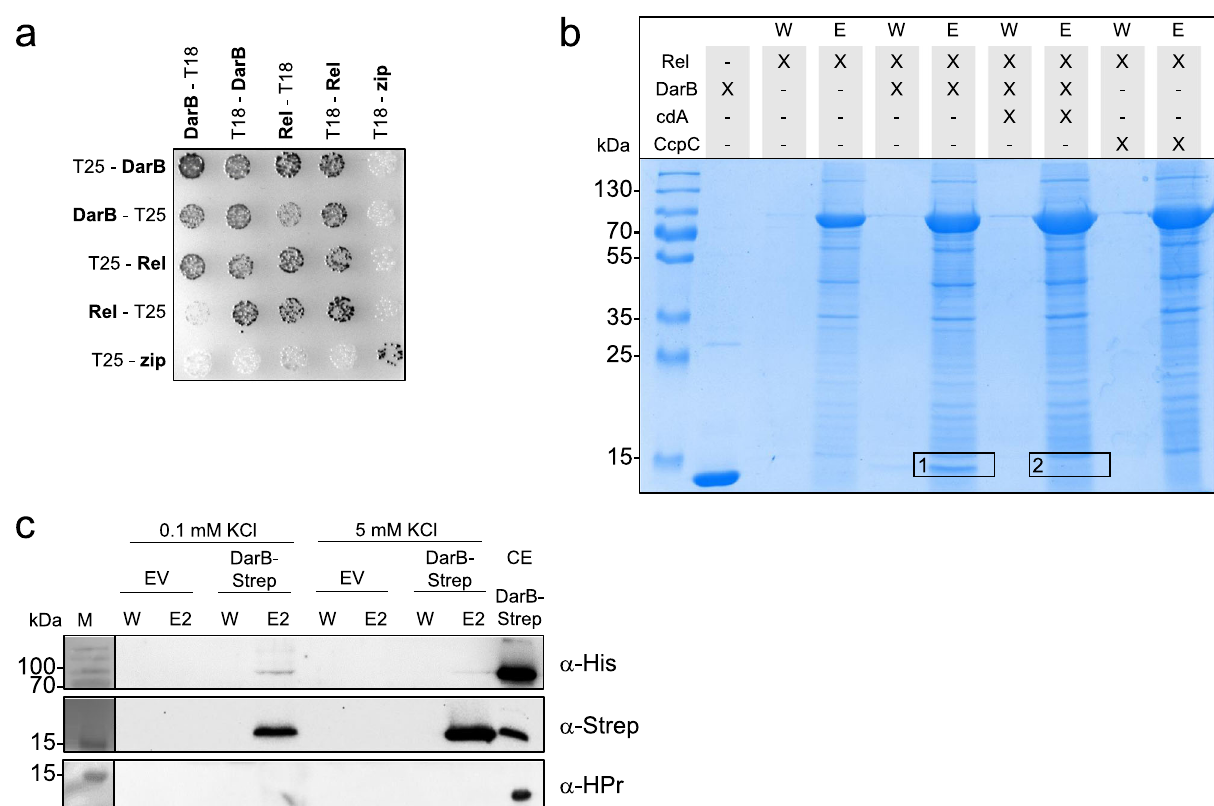
Fig. 1 DarB interacts with Rel in vitro and in vivo. a Bacterial two-hybrid (BACTH) experiment testing for the interaction of DarB with Rel. N- and C- terminal fusions of DarB and Rel to the T18 or T25 domains of the adenylate cyclase (CyaA) were created and the proteins were tested for interaction in E. coli BTH101. Dark colonies indicate an interaction that results in adenylate cyclase activity and subsequent expression of the reporter β -galactosidase. The experiment was conducted three times and a representative plate is shown. b In vitro Strep-Rel pulldown experiment. Strep-Rel was immobilized onto a StrepTactin column and incubated with DarB, DarB preincubated with c-di-AMP, or the control protein CcpC. The eluates (E) and wash (W) fractions were analyzed by SDS-PAGE and the presence of DarB in the elution fractions was further veri fi ed by MS analysis (excised gel bands are numbered with 1 and 2). The experiment was conducted three times and a representative gel is shown. c In vivo interaction experiment of DarB-Strep with Rel-His. B. subtilis expressing Rel-His 6 was transformed with plasmid-borne DarB-Strep and grown in minimal medium containing low (0.1 mM) or high (5 mM) potassium concentration. DarB together with its potential binding partners was puri fi ed with a StrepTactin column and the elution and wash fractions were analyzed by western blot analysis. DarB and Rel were detected by using antibodies against the Strep-tag and the His-tag, respectively. HPr served as a negative control. EV, empty vector; CE, cell extract; cdA, c-di-AMP. The western blot was conducted three times and a representative gel is